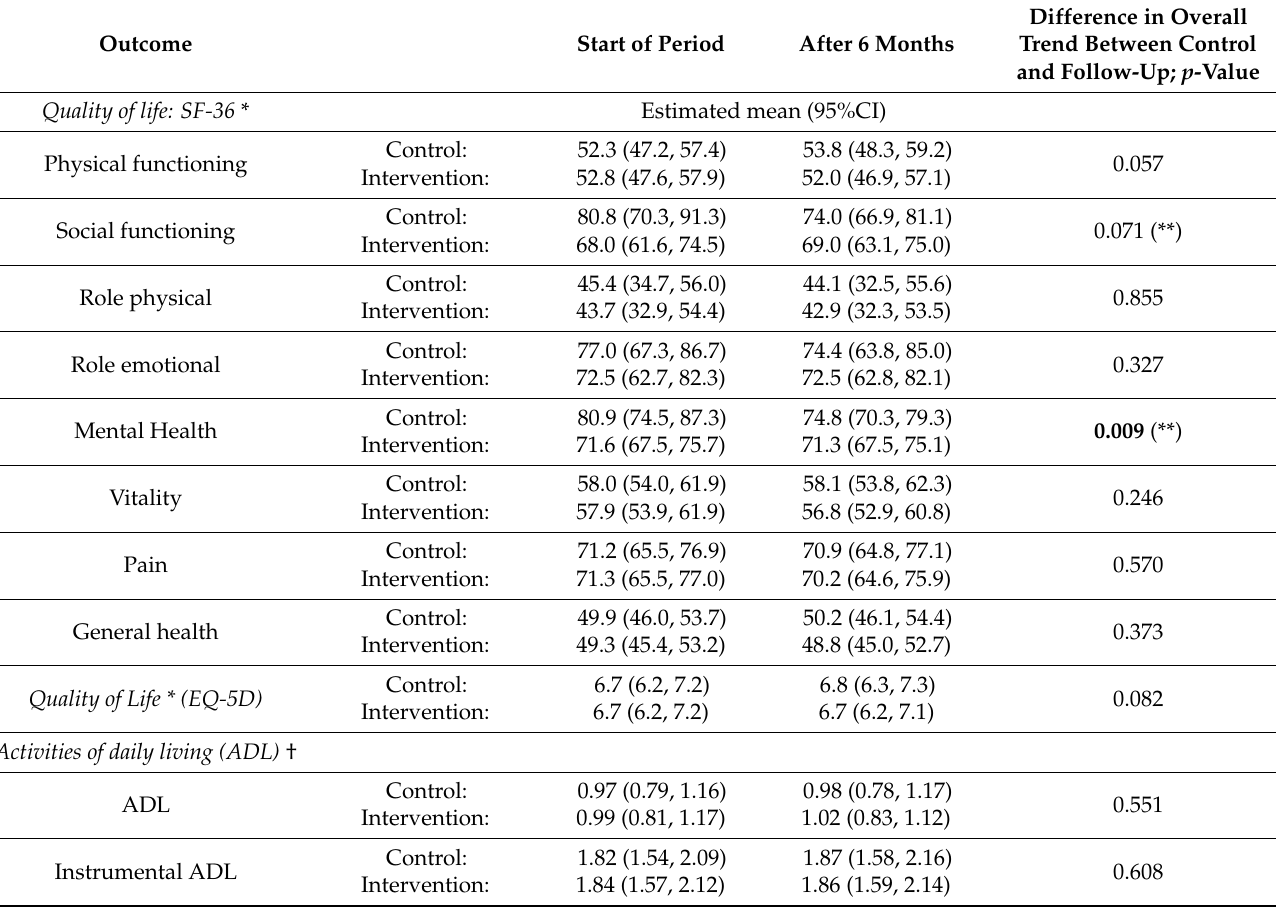
Table 4. Effects of a comprehensive medication review in patients with polypharmacy in primary care; results of a Linear Mixed Model Analysis of patient outcomes comparing control and intervention at start of period and after six months ( N = 746–752)